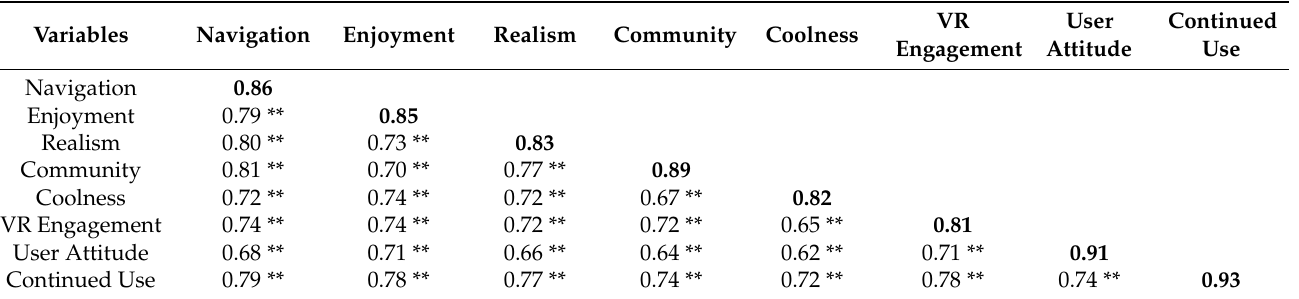
Table 2. Inter-correlation between the constructs and the square root of AVEs (Fornell–Larcker criterion).